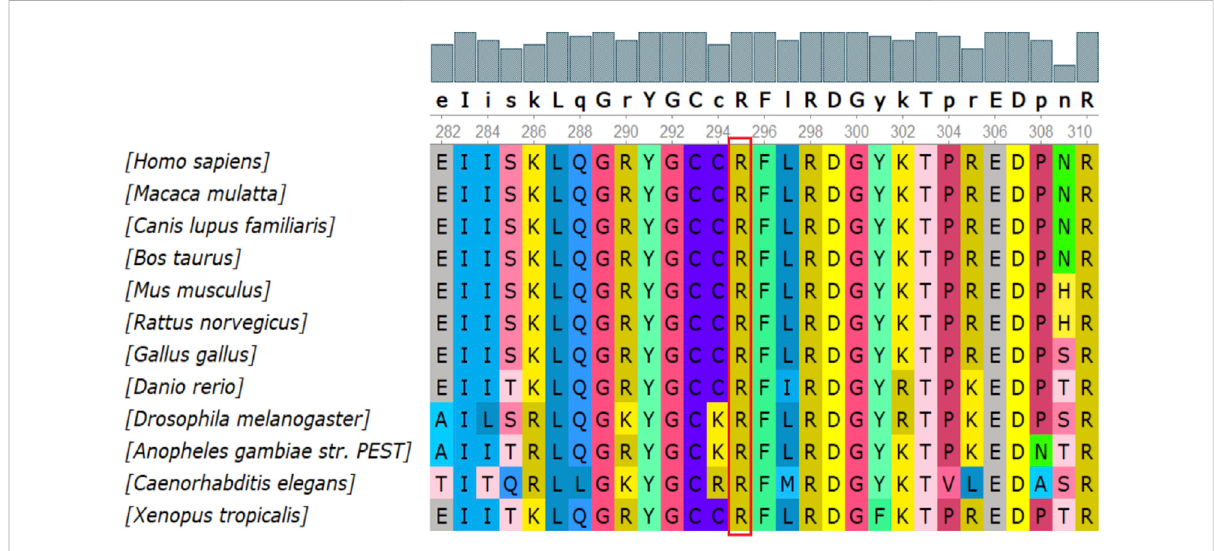
FIGURE 2 Conservationanalysisofthep.Arg295Glymutationin PHKA2 .Silicoanalysisofp.Arg295in PHKA2 showsthesitehighlyconservativeindifferent species of human, Macaque, canine, Cattle,